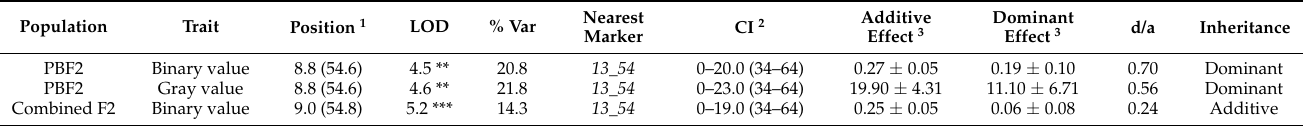
Table 3. Summary of QTLs for eye pigmentation on chromosome 13 identified in this